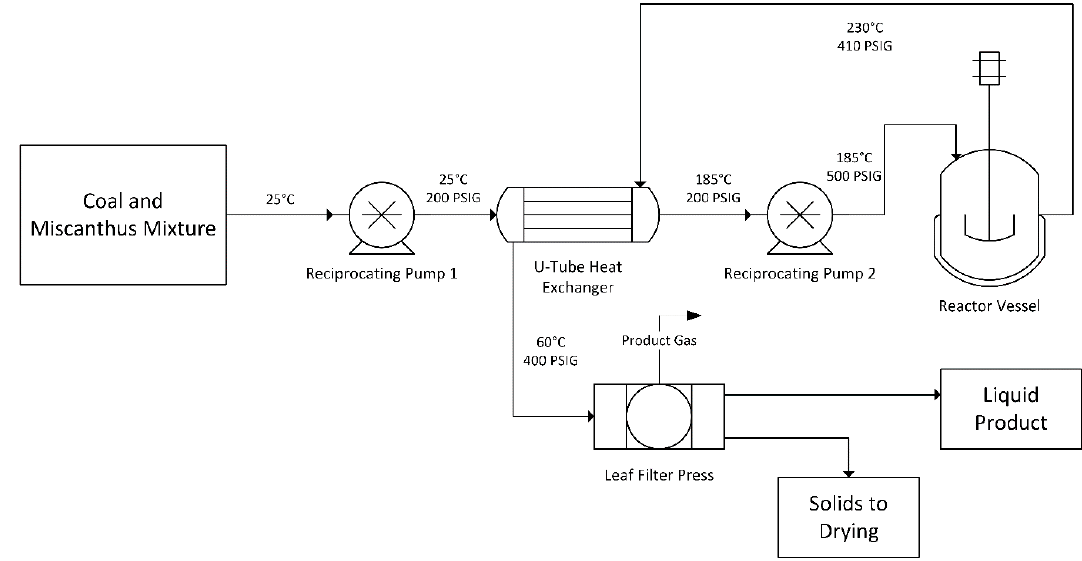
Figure 1. Simplified process flow diagram of Co-Hydrothermal Carbonization (Co-HTC) treatment used for economic analysis.